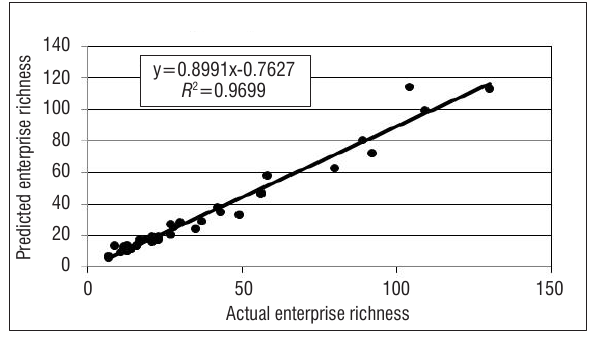
(Figure 6). The comparisons used town size ranges limited to the maximum size of Free State towns in 1946/1947 (i.e. 947 enterprises in Bloemfontein). In each case, the actual number of enterprises of a